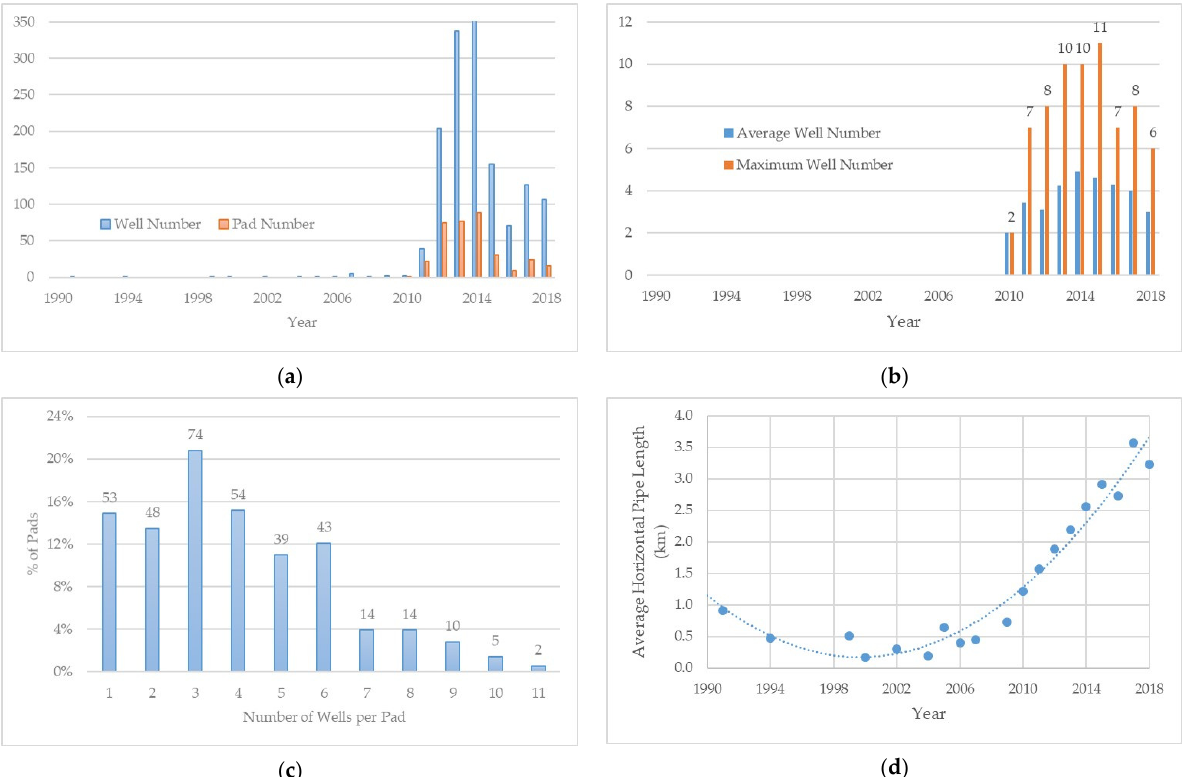
Figure 7. Temporal development of shale gas extraction activities in the Muskingum River Watershed: ( a ) the shale gas well number and well pad number each year; ( b ) the average and maximum shale gas well number per well pad each year; ( c ) number of shale gas wells per pad as a function of the percentage of all pads; ( d ) average length of horizontal pipes in each year.